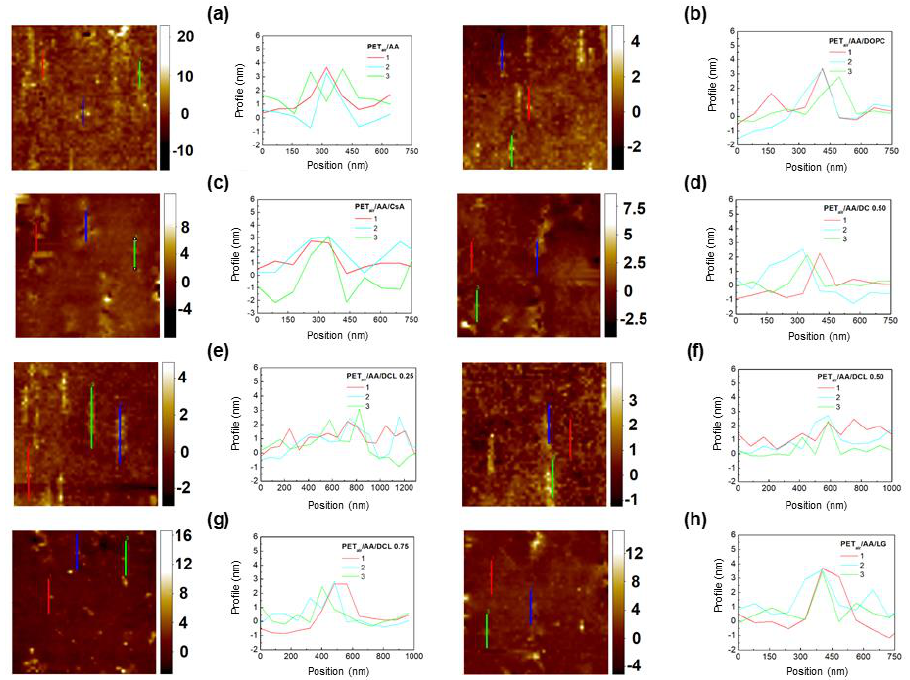
Figure 5. AFM zoomed micrographs and profiles obtained for: PET air /AA ( a ), PET air /AA/DOPC ( b ), PET air /AA/CsA ( c ), PET air /AA/DOPC-CsA 0.50 ( d ), PET air /AA/DOPC-CsA-LG 0.25 ( e ), PET air /AA/DOPC-CsA-LG 0.50 ( f ), PET air /AA/DOPC-CsA-LG 0.75 ( g ), PET air /AA/LG ( h ). Z scale: nm